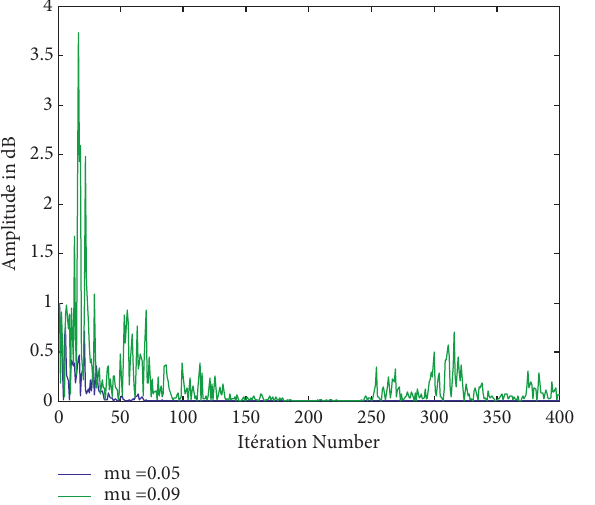
Variance of Noise =0.001 Variance of noise=0.009 Variance of noise=0.01 Figure 8: Effect of noise on CM